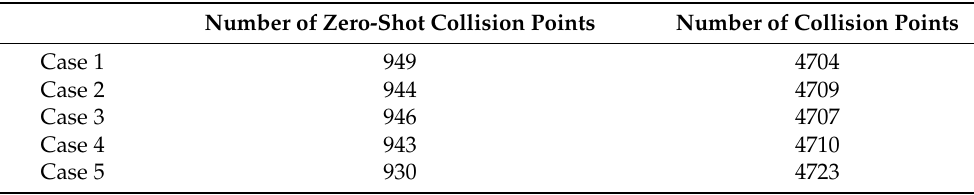
Figure 1. The distribution of zero-shot collision points and collision points. Table 1. The total number of zero-shot collision points and collision points in different cases.